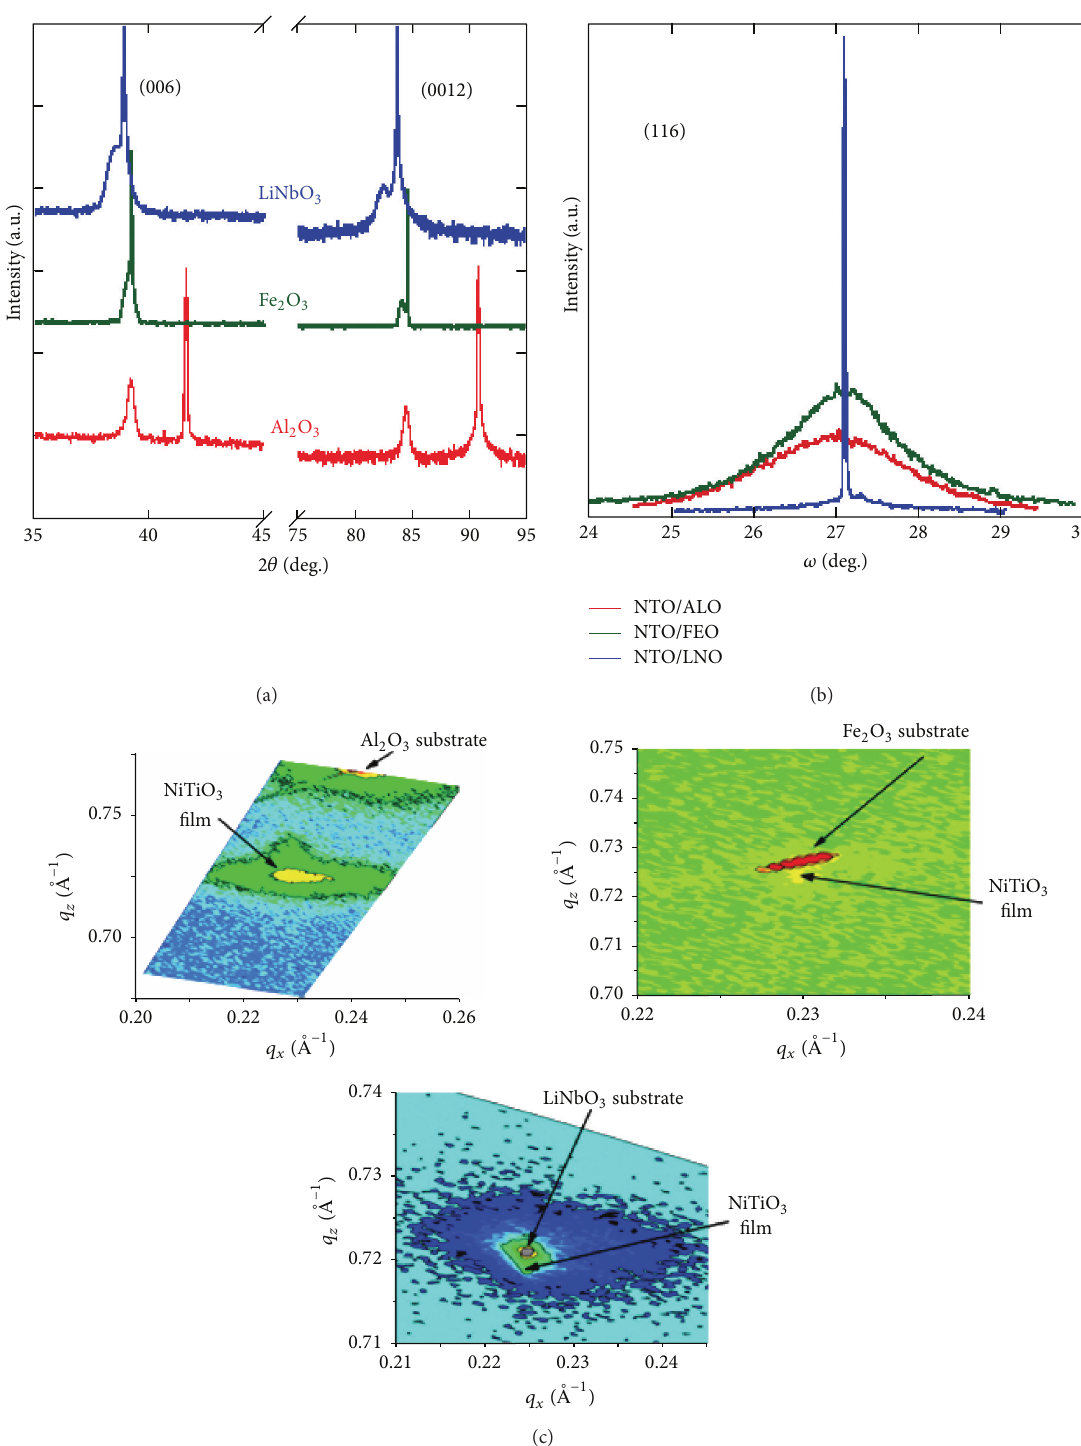
Figure 2: (Color online) (a) Representative high-resolution 2 𝜃 - 𝜃 XRD pattern of NiTiO 3 /Al 2 O 3 , NiTiO 3 /Fe 2 O 3 , and NiTiO 3 /LiNbO 3 films showing (001)-oriented epitaxial films. (b) Representative in-plane (116) rocking curves for NiTiO 3 /Al 2 O 3 , NiTiO 3 /Fe 2 O 3 , and NiTiO 3 /LiNbO 3 films. (c) (1010) Reciprocal space maps for NiTiO 3 /Al 2 O 3 , NiTiO 3 /Fe 2 O 3 , and NiTiO 3 /LiNbO 3 films. Data collected using Cu K 𝛼 (1.54056 ˚A)